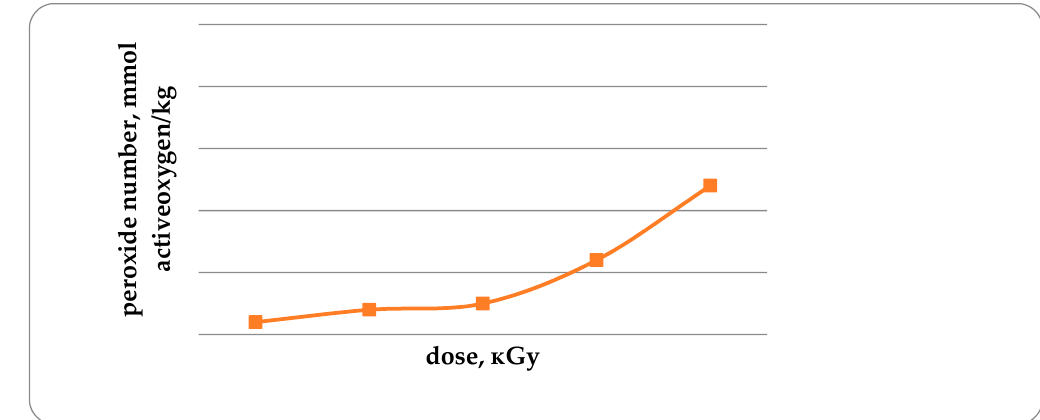
Figure 8. Peroxide number in trout samples, mmol of active oxygen/kg ( p ≤ 0.01) .